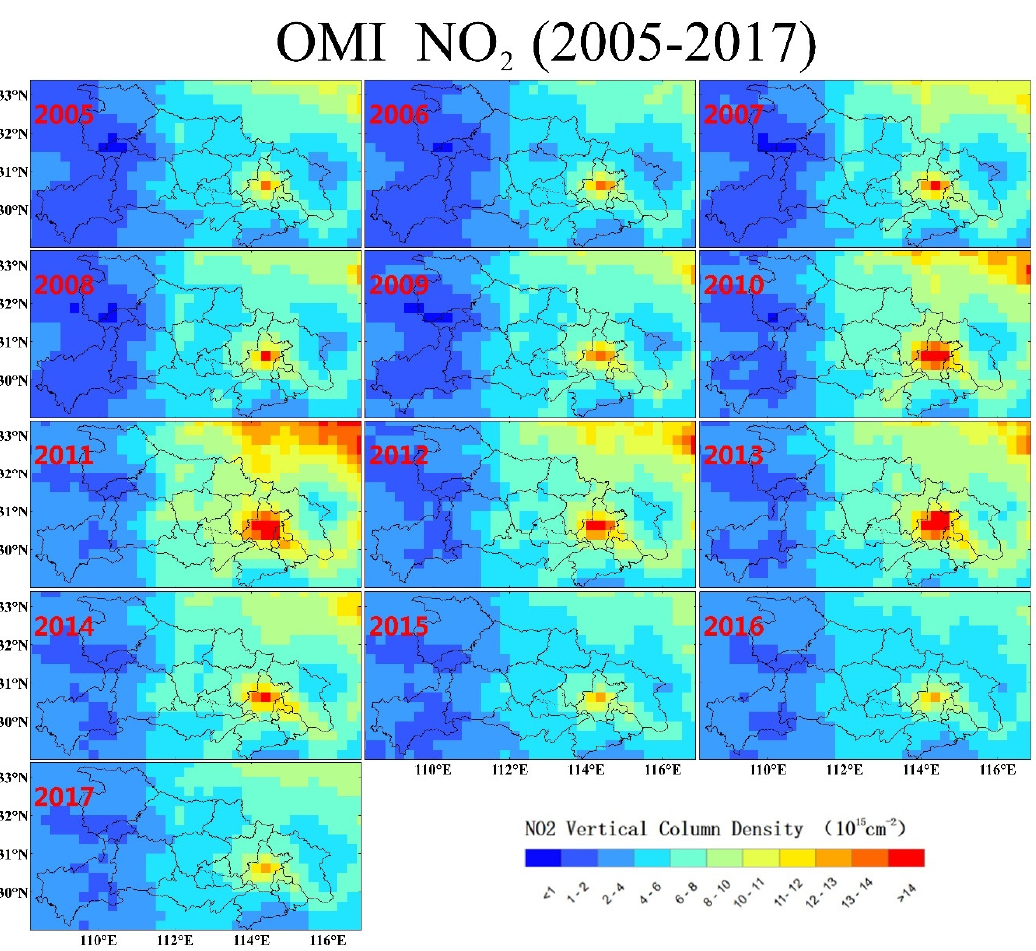
Figure 5. Spatial and temporal distribution of annual OMI nitrogen dioxide (NO 2 ) VCD over Hubei province during 2005–2017.